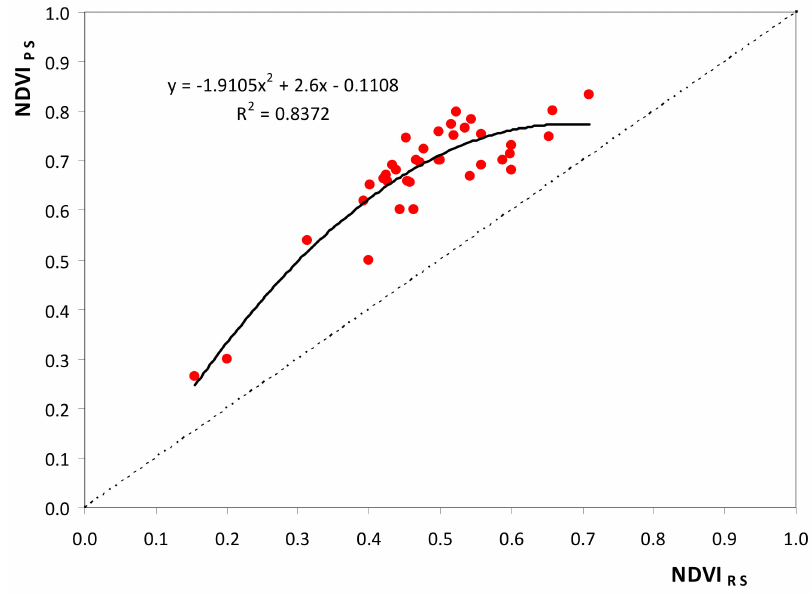
Figure 8. Normalized difference vegetation index (NDVI): correlation between proximal sensing (NDVI PS ) and remote sensing (NDVI RS